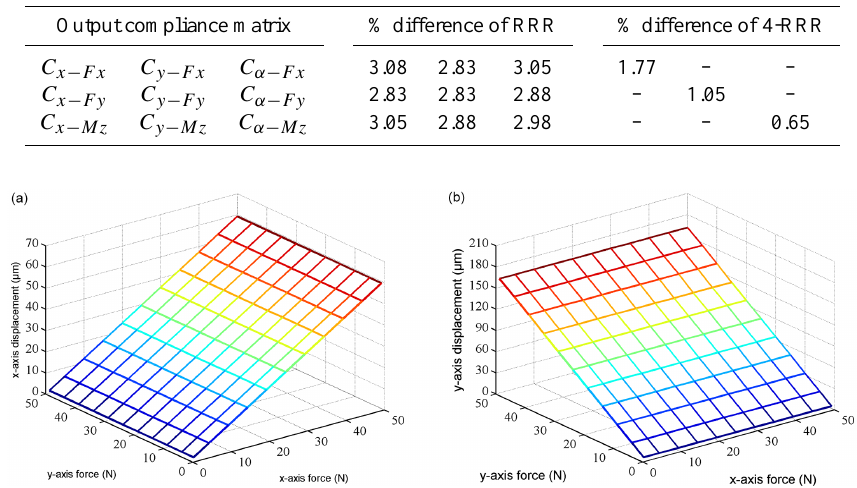
Table 2. The differences between the analytical and FEA results.